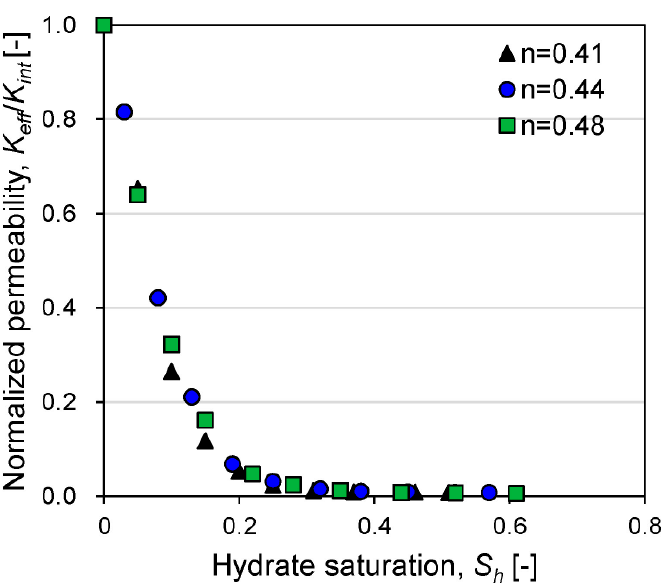
Figure 6. Relative permeability curve [33].